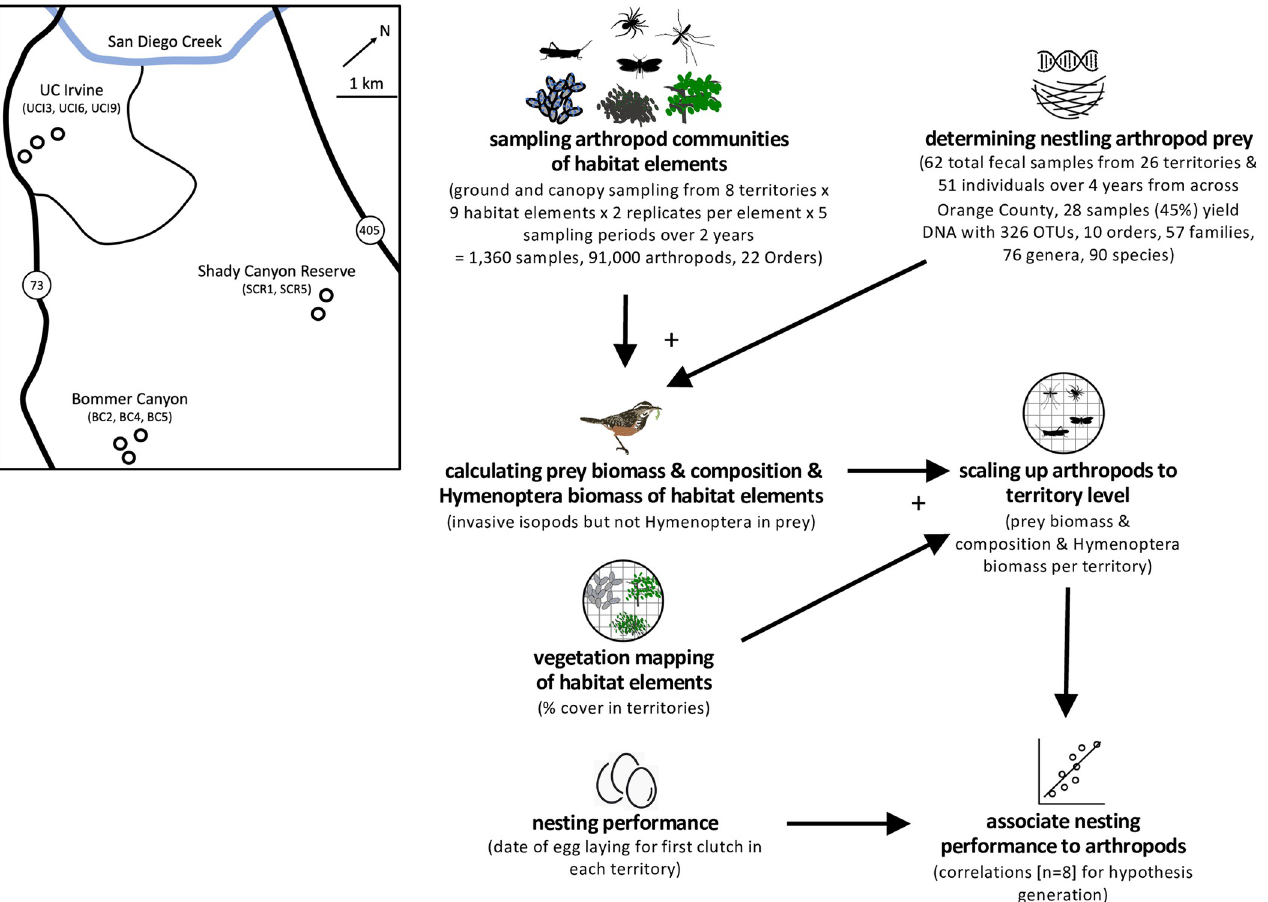
Fig 1. Overview of experimental design. The map identifies the location of the eight studied Cactus Wren territories within Orange County. The flow chart indicates the different data sources and sample sizes and how they are integrated in analyses. Details on each data stream and analyses procedures are provided in Methods